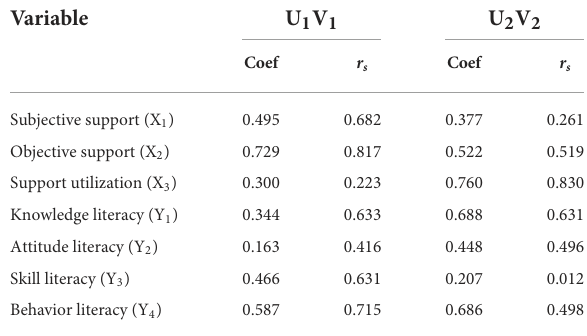
TABLE 3 Canonical correlation analysis of medication literacy and social